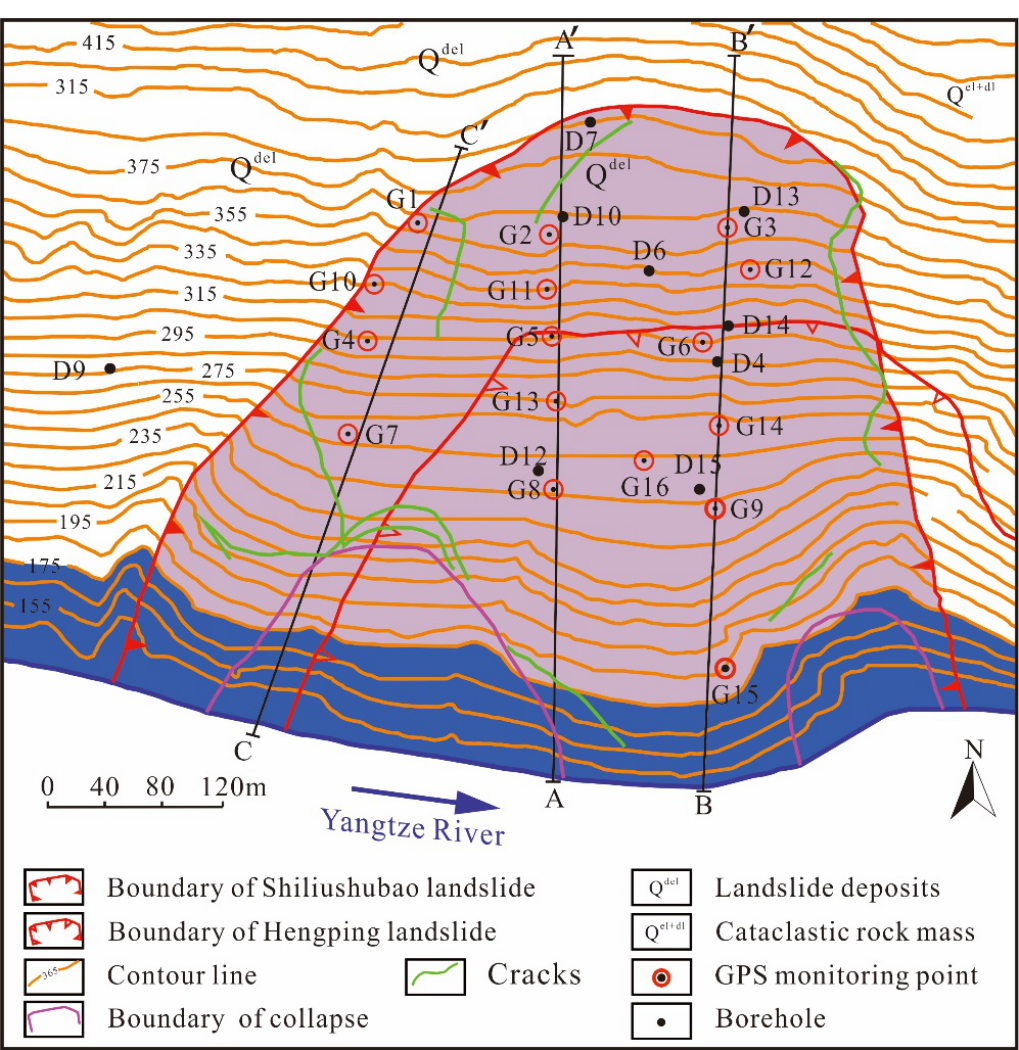
Figure 5. Geological map and monitoring points for the Shiliushubao landslide.